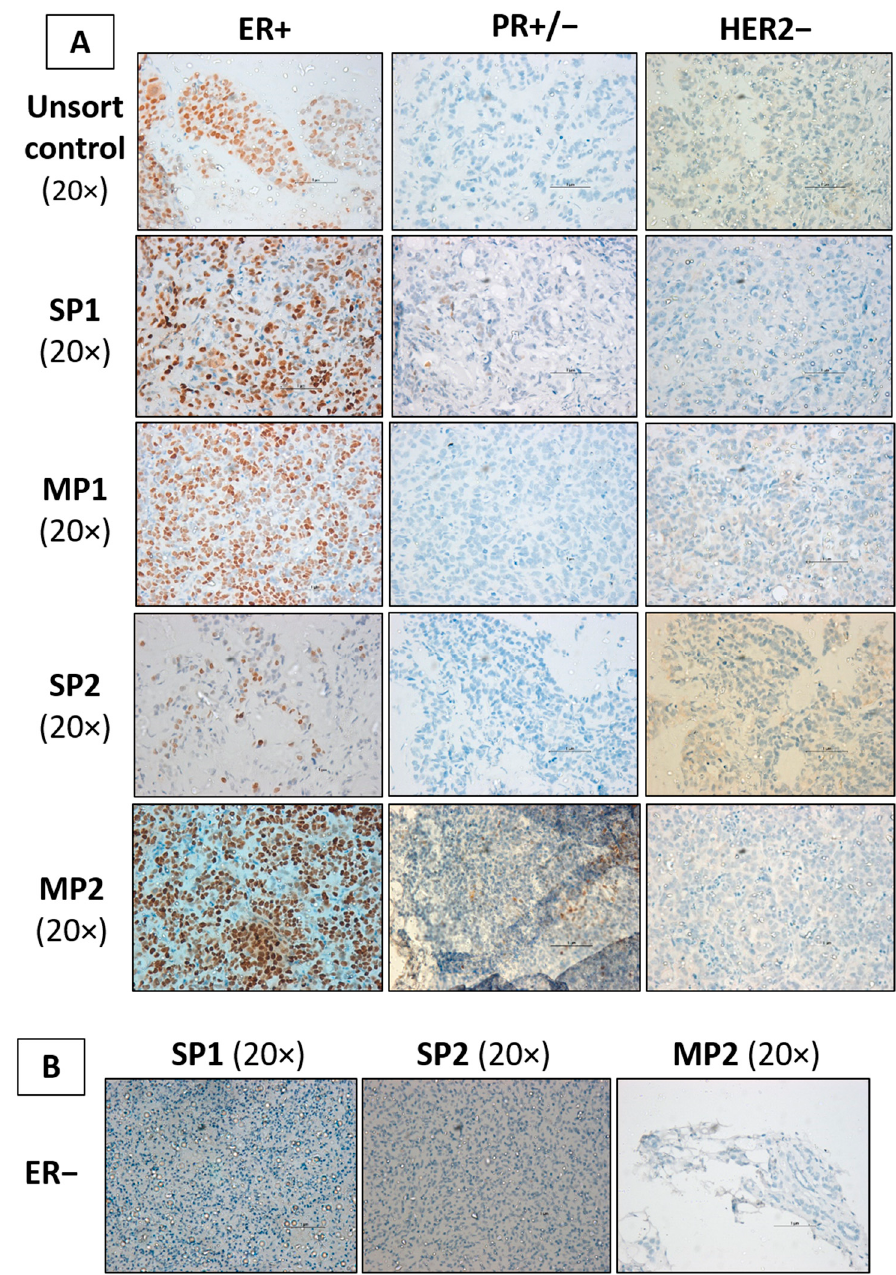
Figure 4. IHC-based expression profiling of hormone receptor proteins. ( A ) The xenografts generated from different fractions in NSG mice were screened for the hormone receptor profile via immunohistochemistry staining. Few samples differed from the parental MCF7 phenotype to develop (ER+/PR − /HER2 − ) the luminal A subtype with a loss of PR protein expression (PR − ). ( B ) The loss of estrogen (ER) and progesterone (PR) receptors in SP1 (85 days), SP2 (120 days), and MP2 (90 days) fractions lead to the (ER − /PR − /HER2 − ) phenotype. The development of variants across a time period was suggestive of the delayed recurrence and emergence of new subtypes in ER+ breast cancers (scale bar measures 1 µm).